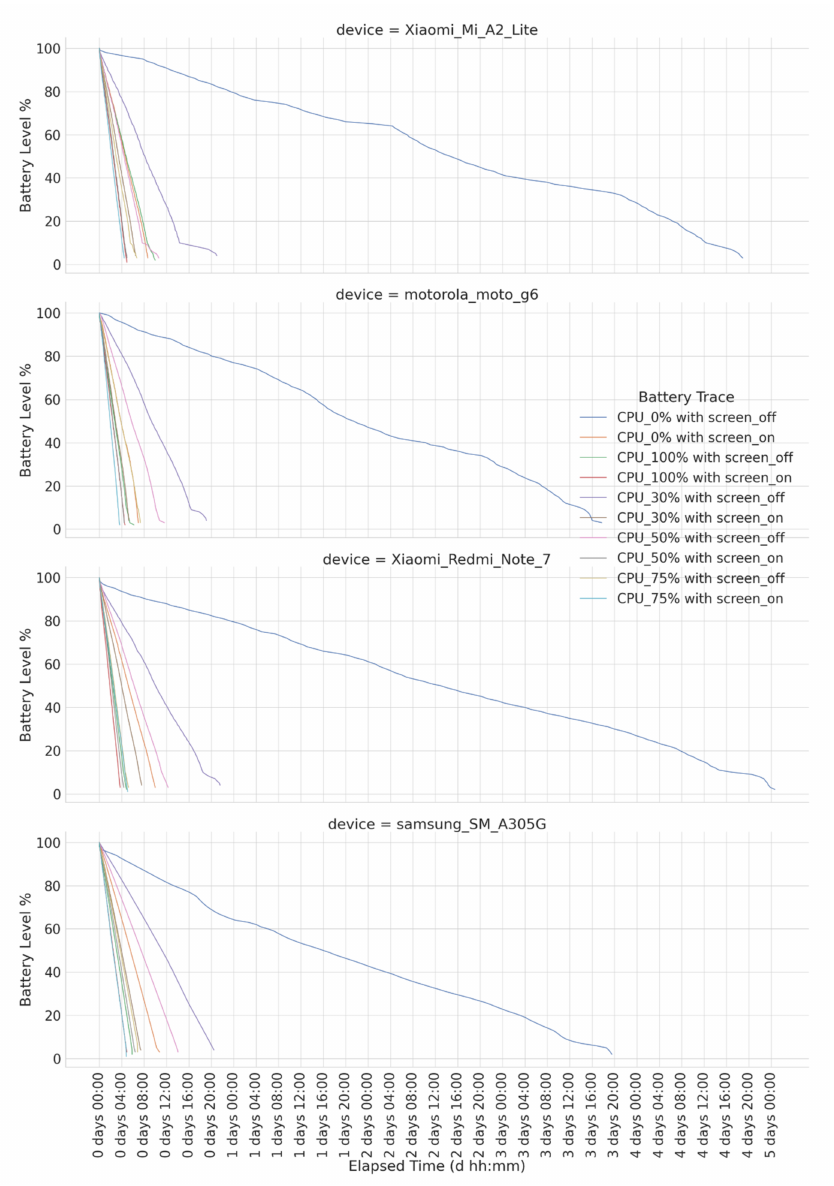
Figure 4. Discharging traces for smartphones considered in the